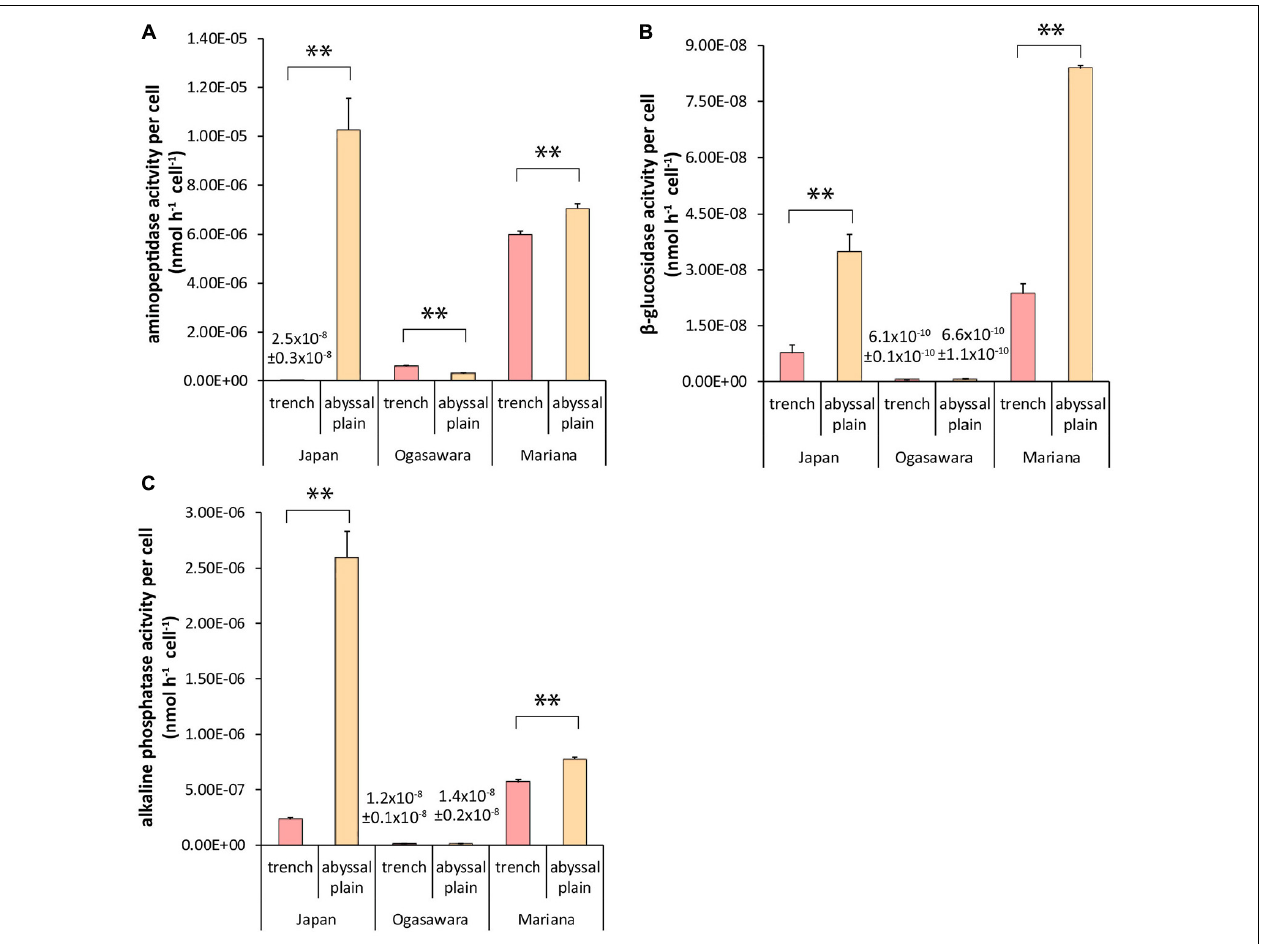
FIGURE 3 | Extracellular enzymatic activities per prokaryotic cell: (A) specific aminopeptidase activity, (B) specific β -glucosidase activity, and (C) specific alkaline phosphatase activity. Reported are the mean values and related SDs for each hadal trench site and related abyssal site. Statistical significance is tested between hadal trenches and abyssal sites. ∗∗ p < 0.01.